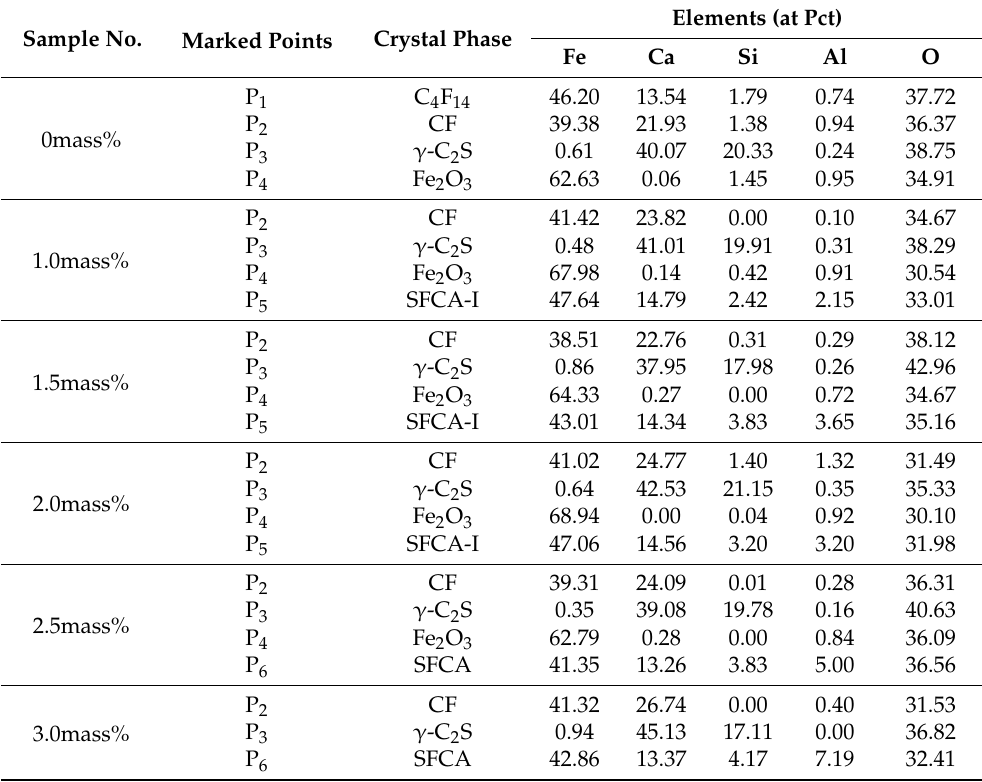
Table 2. EDS results of the crystallized phases in the samples under 0.02 ◦ C/s. Sample No. Marked